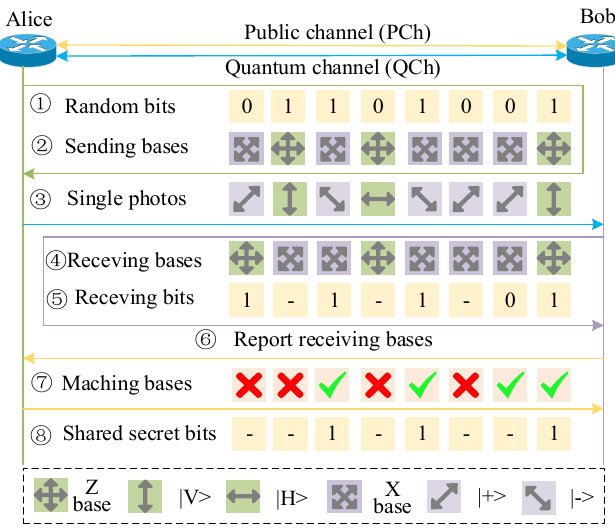
Figure 1. Point-to-point quantum-key-distribution (QKD) mechanism based on the four-state protocol originally proposed by Bennett and Brassard in 1984 (BB84).